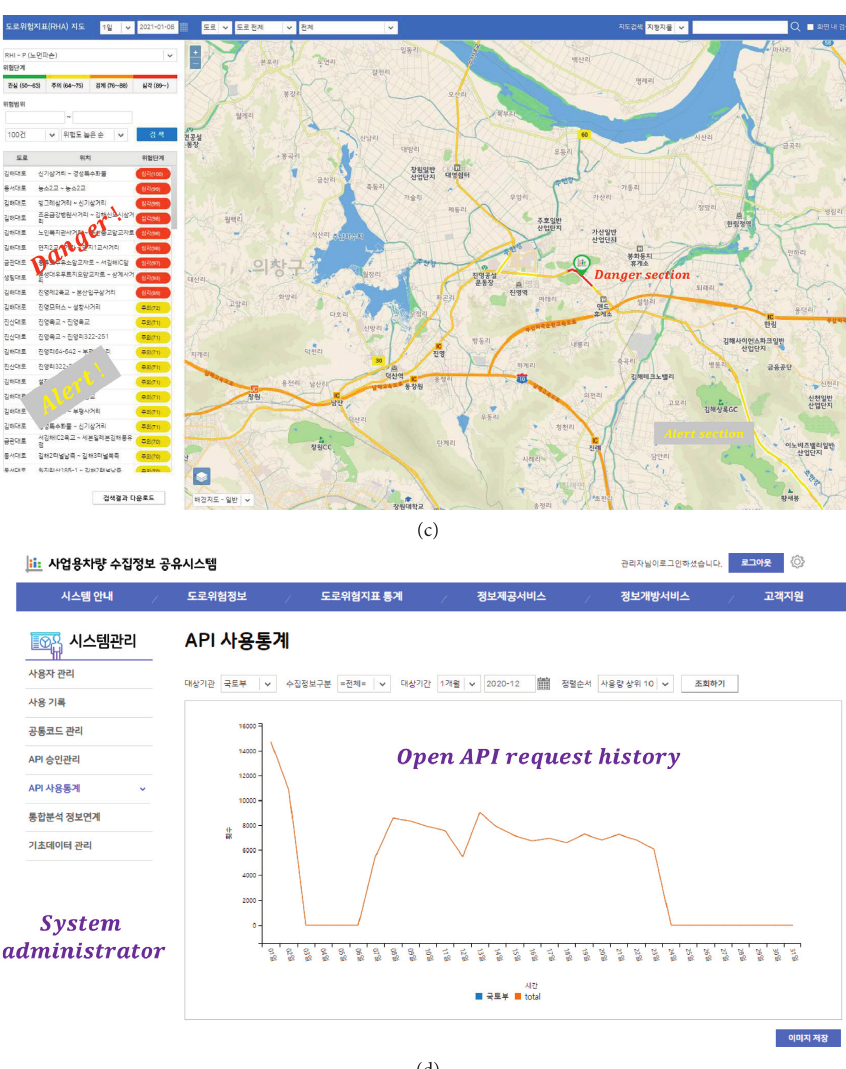
Figure 4: DAISS development results. (a) Main menu. (b) Road hazard index statistics. (c) GIS map-based information platform. (d) DAISS usage statistics.